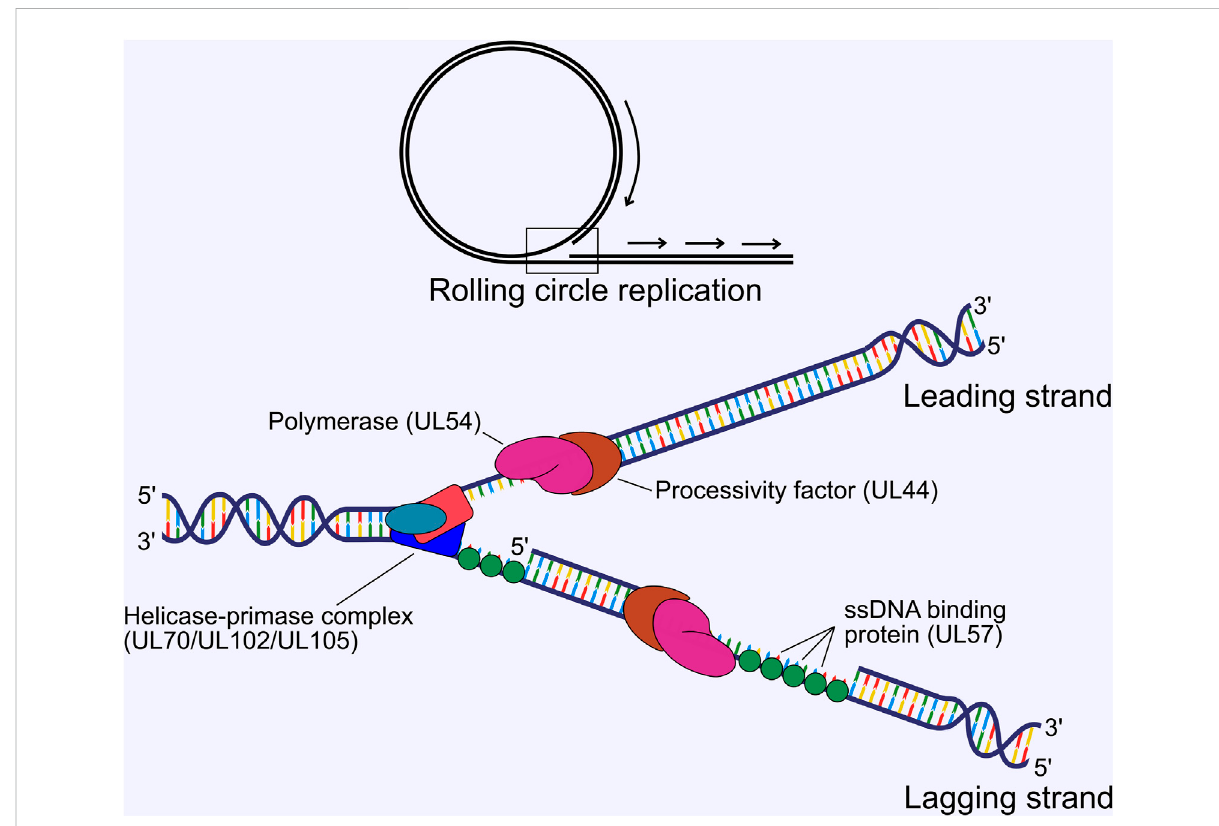
FIGURE 4 Viral DNA replication proceeds by a rolling circle mechanism to produce linear concatemers. The tripartite helicase-primase complex composed of UL70, UL102 and UL105 separates the strands to form a replication fork, while the DNA polymerase (UL54) and processivity factor (UL44) synthesise the daughter strands by leading and lagging strand synthesis. The ssDNA binding protein UL57 forms fi laments on ssDNA, which stimulates polymerase and primase activity. ssDNA, single stranded DNA.